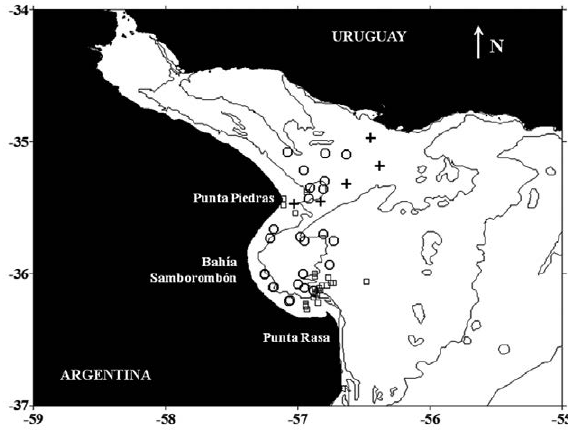
Fig. 3. – Location of the stations used for validation of satellite- derived estimates of SPM (mg l –1 ) during the research cruises: PWC2012, PWC2013 and PWC2014 (open circles), Punta Rasa 02, 06 and 07, Punta Piedras 01 and 02 (open squares) and FREPLATA- FFEM